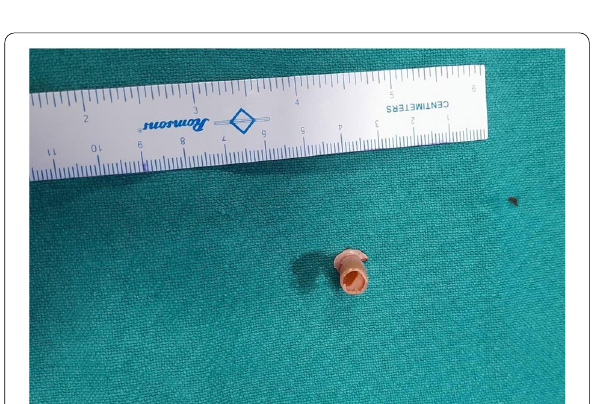
Fig. 3 Removed foreign